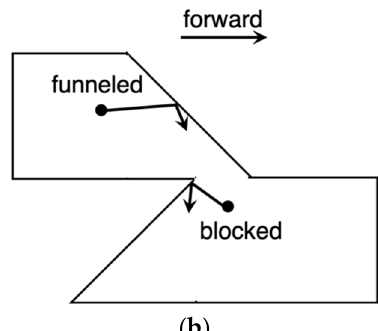
Figure 3. ( a ) Geometric effect in the inverse-arrowhead diode and ( b ) geometric effect in the Z-diode. In both cases, charges are funneled through in the forward direction and blocked in the reverse direction. The reverse blockage is more effective in the Z-diode.